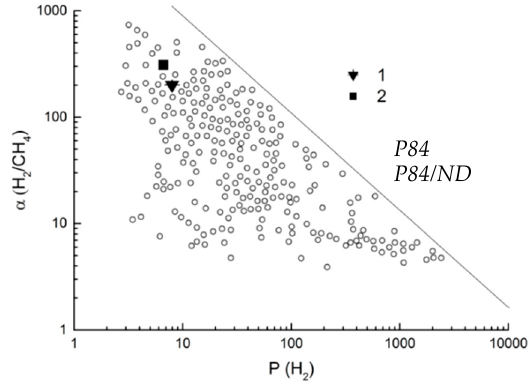
Figure 8. Robeson diagram for hydrogen/methane gas pair [50].